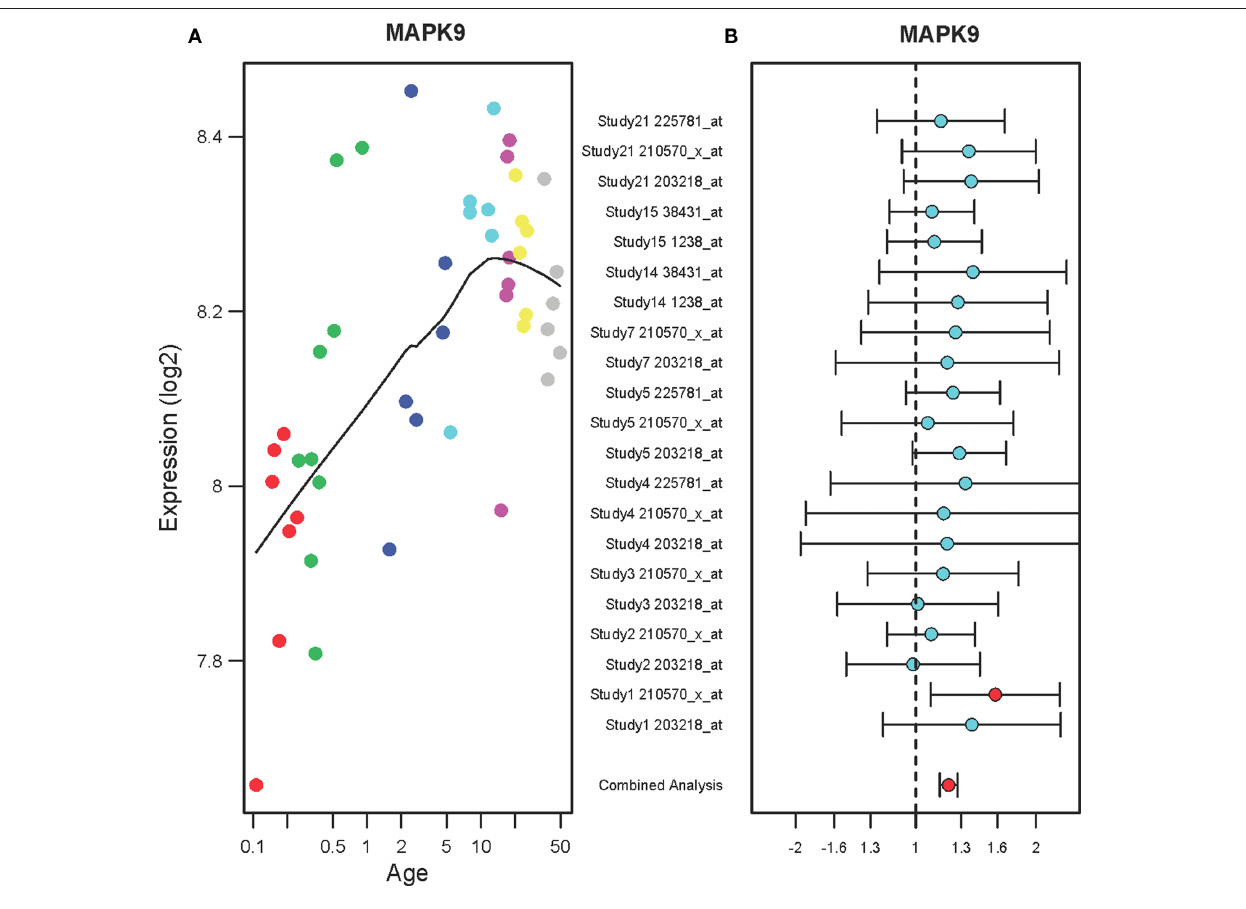
changes and 95% confidence intervals shows consistent up-regulation of MAPK9 in the PFC of suicide victims as compared to the non-suicide controls across nine microarray studies. A combined analysis shown on the bottom represents the weighted fold change and 95% confidence intervals. Individual microarray probes for MAPK9 across multiple studies are shown on the left (Study ID and Affymetrix probe ID). Red point: adjusted p < 0.05, Cyan point: adjusted p